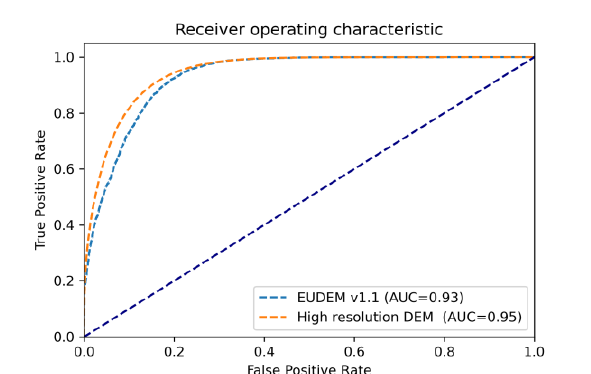
Figure 3. Model estimation performance from ROC curves of both datasets.